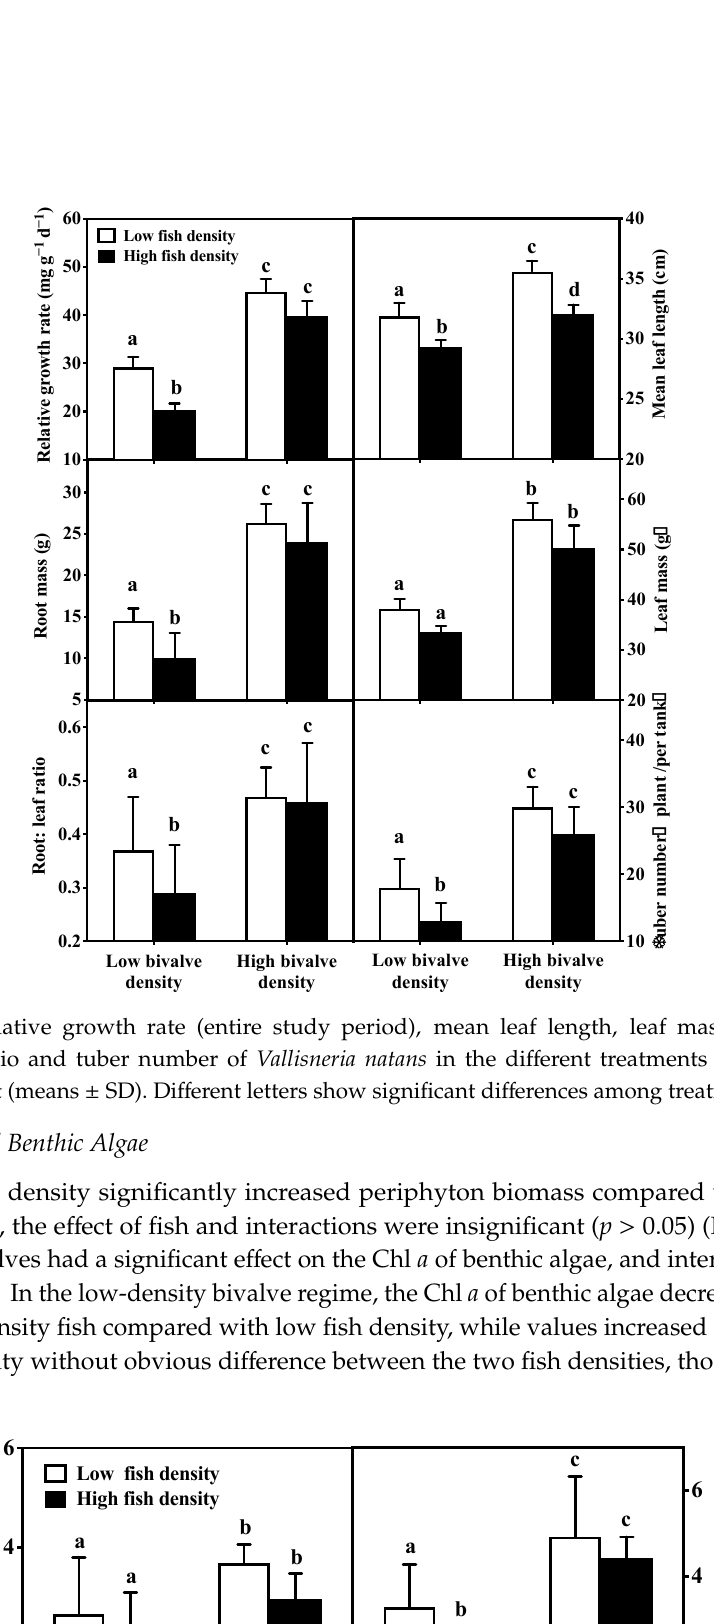
10 of 19 Figure 6. Nitrogen (N), phosphorus (P) and the carbon:phosphorus (C:P) and carbon:nitrogen (C:N) ratios of Vallisneria natans in the different treatments at the end of the experiment (means ± SD). Different letters show significant differences among treatments. Both fish and bivalves greatly affected the growth and reproduction of V. natans ( p < 0.05) (Figure 7, Table 2). All the plant indices significantly decreased proportionally to the increasing fish density (except leaf mass) but were promoted by increased bivalve density. The interaction terms were only significant for relative growth rates, root mass, root:shoot ratio and tuber numbers with differences